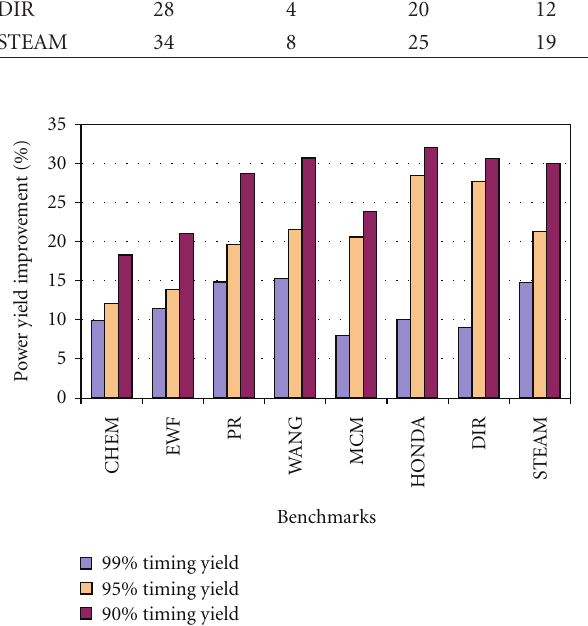
Figure 15: Power yield improvement against deterministic worst- case approach with asynchronous level conversion and di ff erent timing yield constraints.